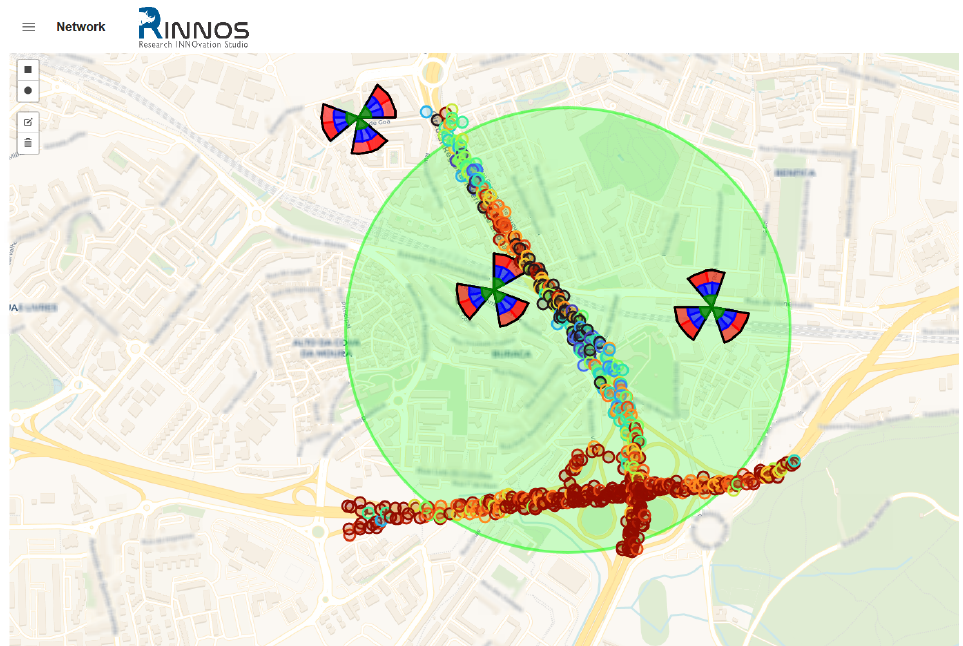
Figure 11. The failure location (green circle) and available DT measurements as a function of the received